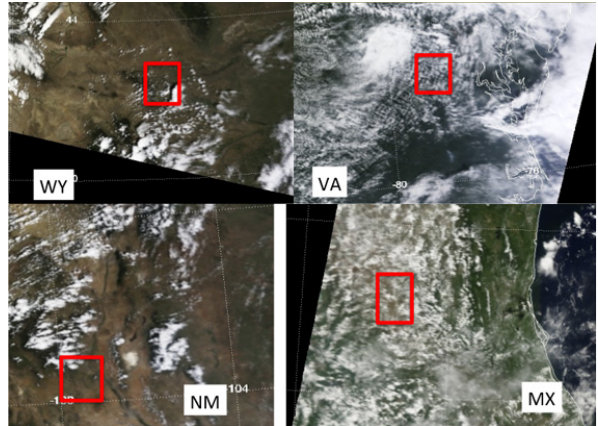
Fig. 9. Terra MODIS true color imagery of four local areas on 12 August 2010. The red box in each image represents a 1-degree square used to define a local region in the analysis. The four re- gions are Virginia (VA), Wyoming (WY), New Mexico (NM) and Mexico